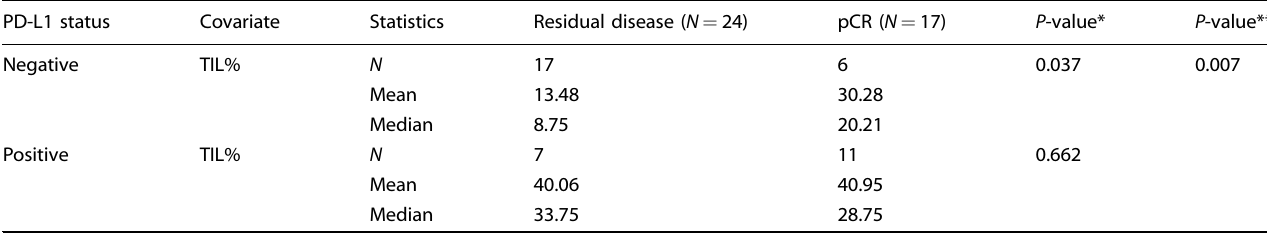
Table 3. Baseline TIL (%) by PD-L1 and pCR status (Arms A and B). PD-L1